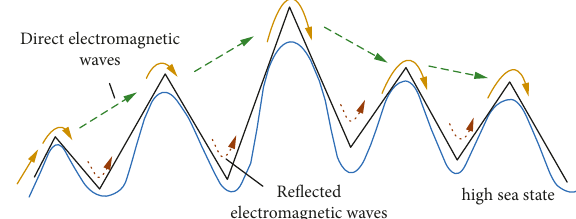
Figure 5: Equivalent model of the multi-edge diffraction model.